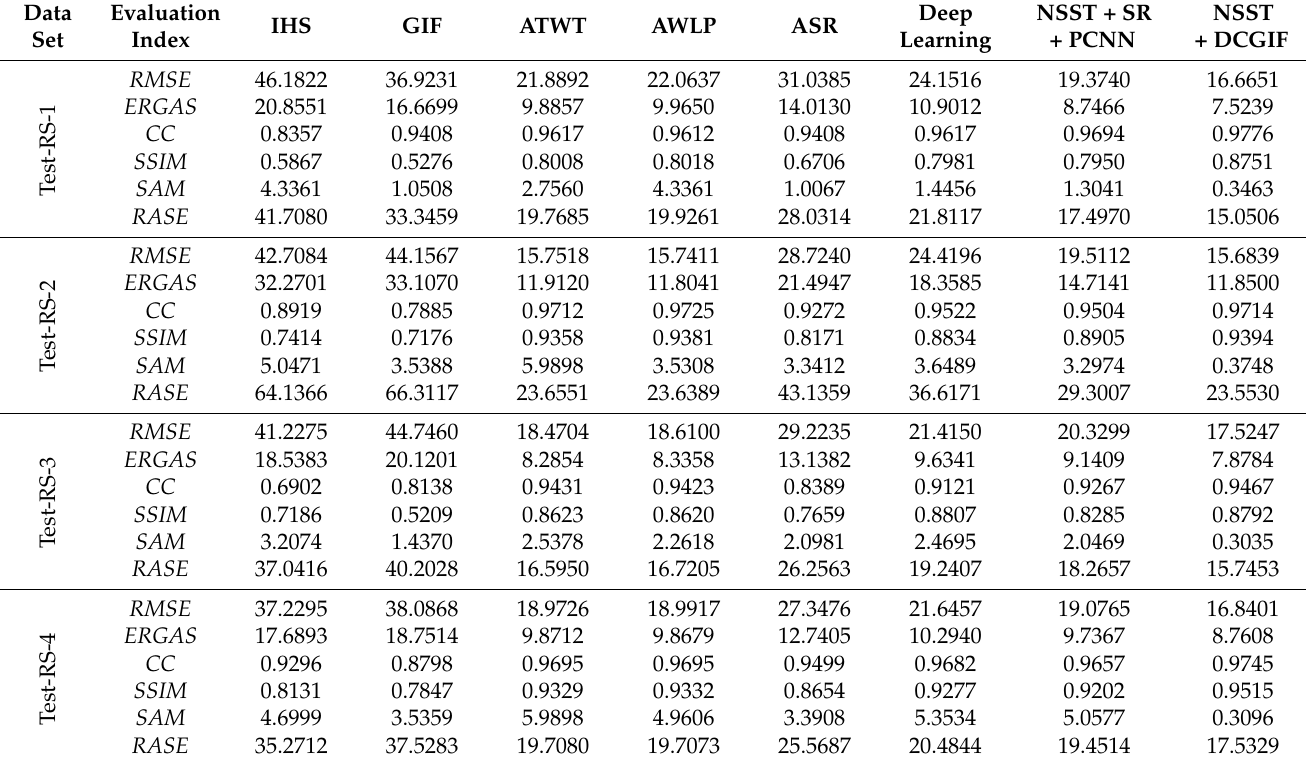
Table 4. Objective evaluation of degraded